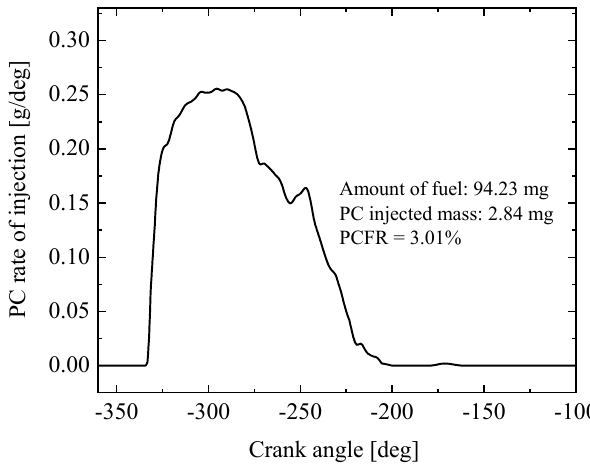
Figure 2. Pre-chamber fueling profile. Table 2. Specifications of load and boundary conditions